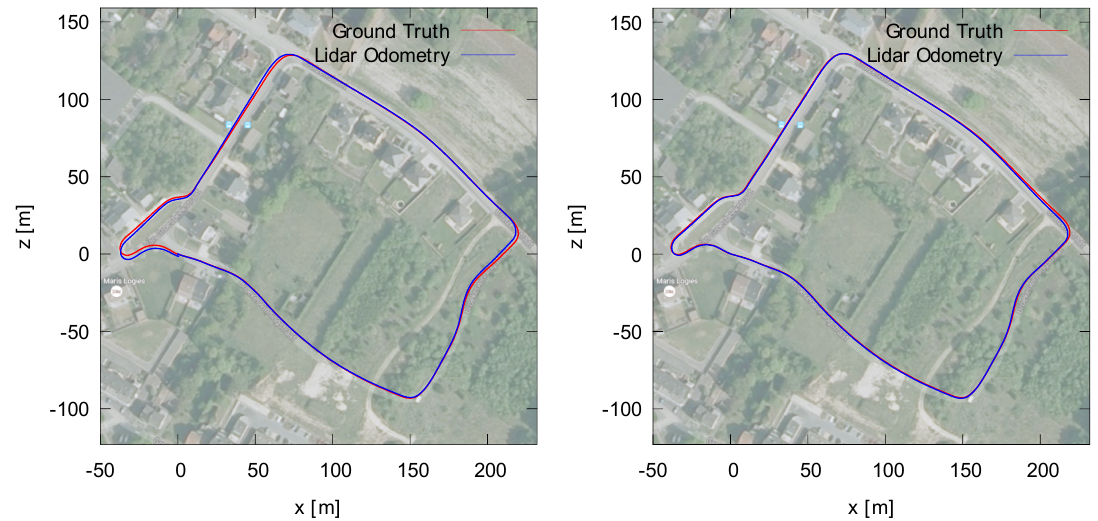
Figure 9. The two resulting trajectories for the “Hasselt” dataset corresponding to the reconstructions in Figure 8, before loop closure ( left ) and after loop closure ( right ). The estimated trajectory and the ground truth trajectory are almost entirely overlapping after loop closure. The pose error before and after loop correction is, respectively, 5.56 and 3.13 m, hence proving the effectiveness of the loop